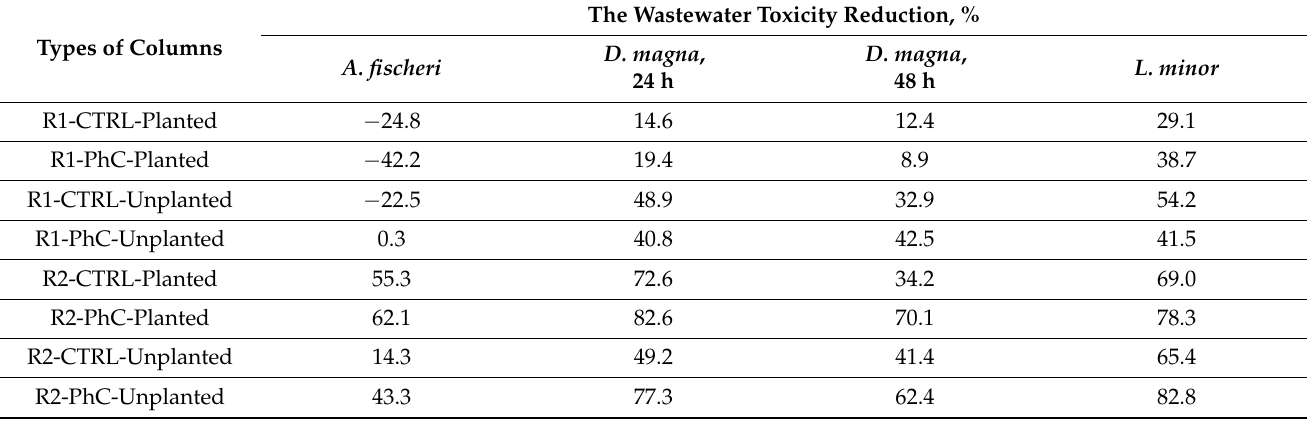
Table A6. Wastewater toxicity reduction as a result of treatment in CWs.